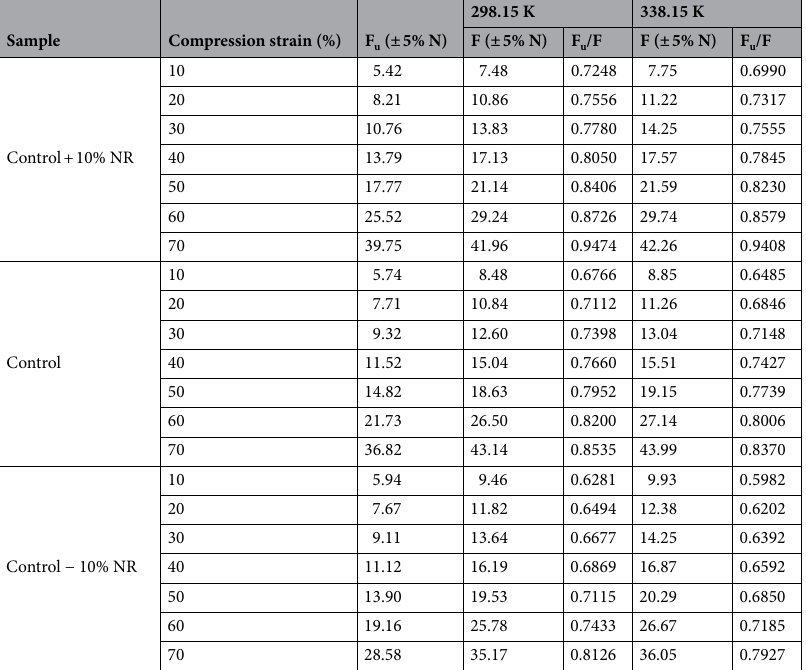
Table 5. Compression strain, F u , F, and F u /F values of foam samples at 298.15 K and 338.15 K.